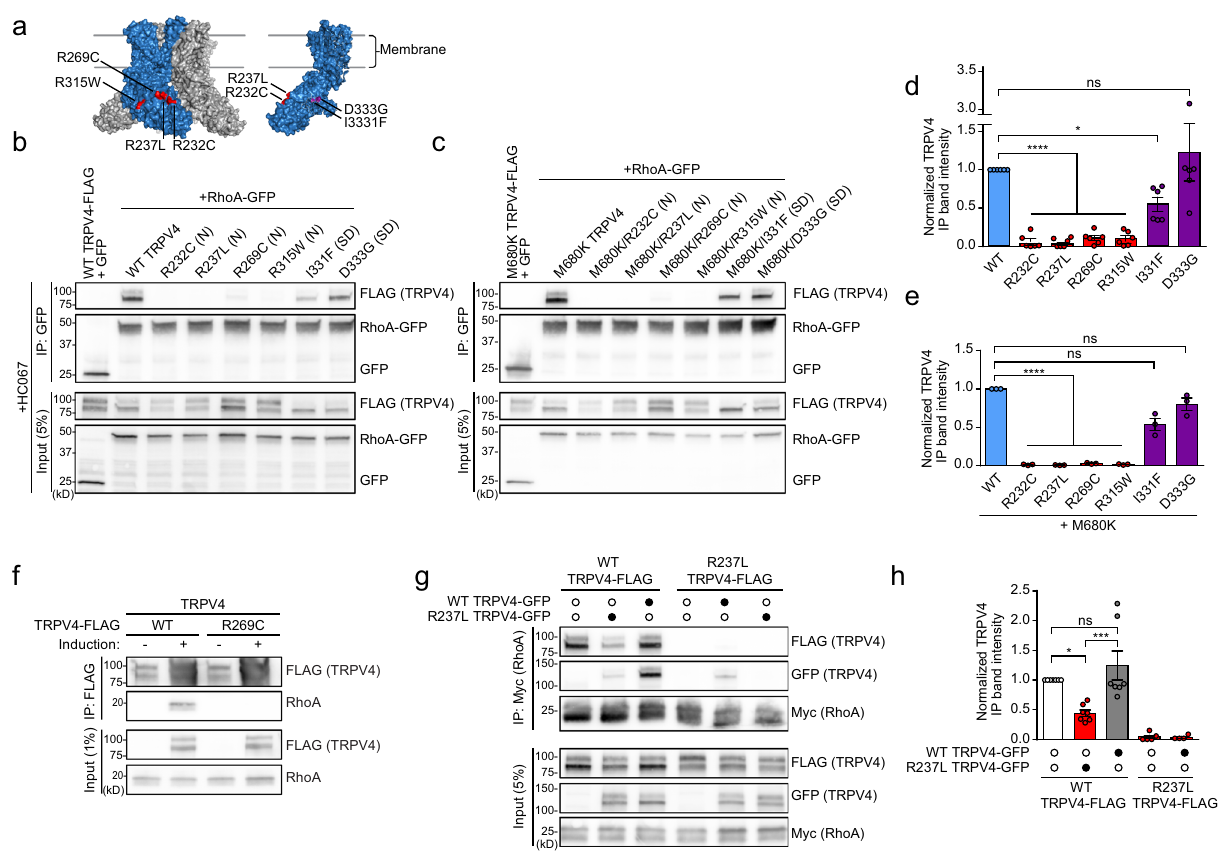
Fig. 2 TRPV4 neuropathy mutations disrupt RhoA interactions. a Schematic showing the structure of the TRPV4 homotetramer ( Xenopus tropicalis , PDB: 6BBJ) with a single subunit in blue. Neuropathy mutations (R232C, R237L, R269C, R315W) are highlighted in red, and skeletal dysplasia mutations (I331F, D333G) within the opposite face of the ARD (rotated for visualization) are highlighted in purple. b , c MN-1 cells were transfected with RhoA-GFP and TRPV4-FLAG with neuropathy-causing mutations (N) or skeletal dysplasia-causing mutations (SD) and treated with the TRPV4 antagonist HC067 (0.5 µ M) ( b ) or RhoA-GFP and TRPV4-FLAG harboring an ion channel pore-inactivating mutation, M680K, either alone or in combination with neuropathy-causing mutations (N) or skeletal dysplasia-causing mutations (SD) ( c ). Cell lysates were then subjected to immunoprecipitation with anti-GFP antibody. Neuropathy mutations, but not skeletal dysplasia mutations, disrupt interaction between TRPV4 and RhoA, independent of calcium-mediated cytotoxicity. d , e Quanti fi cation of densitometry of immunoprecipitated TRPV4 band intensity divided by TRPV4 input band intensity, normalized to WT TRPV4 (( d ); representative blot shown in b ) or M680K TRPV4 (( e ); representative blot shown in c ). One-way ANOVA with Tukey post hoc test, n = 6 ( b ) and n = 3 ( c ) independent experiments, * p = 0.035, **** p < 0.0001. f Co-immunoprecipitation using T-Rex-TRPV4 WT or T-Rex-TRPV4 R269C cells demonstrates that WT but not neuropathy mutant TRPV4 interacts with endogenous RhoA. The presence of TRPV4-FLAG in uninduced immunoprecipitation lanes is due to low-level expression leak. g Co-immunoprecipitation of MN-1 cells transfected with TRPV4-FLAG and TRPV4-GFP constructs as well as RhoA-GFP demonstrates that neuropathy mutant TRPV4 reduces interaction of WT TRPV4 with RhoA (compare lane 1 vs. 2). h Densitometry of immunoprecipitated TRPV4 band intensity normalized to WT TRPV4 alone (lane 1); representative blot shown in g . One-way ANOVA followed by Tukey ’ s multiple comparisons test, n = 4 (lane 5), 5 (lane 4), or 7 (lanes 1, 2, and 3) independent experiments, * p = 0.028, *** p = 0.0009. Data are presented as mean± SEM. Further details regarding the number of times experiments were repeated are presented in “ Methods ” under “ Statistics and reproducibility ”